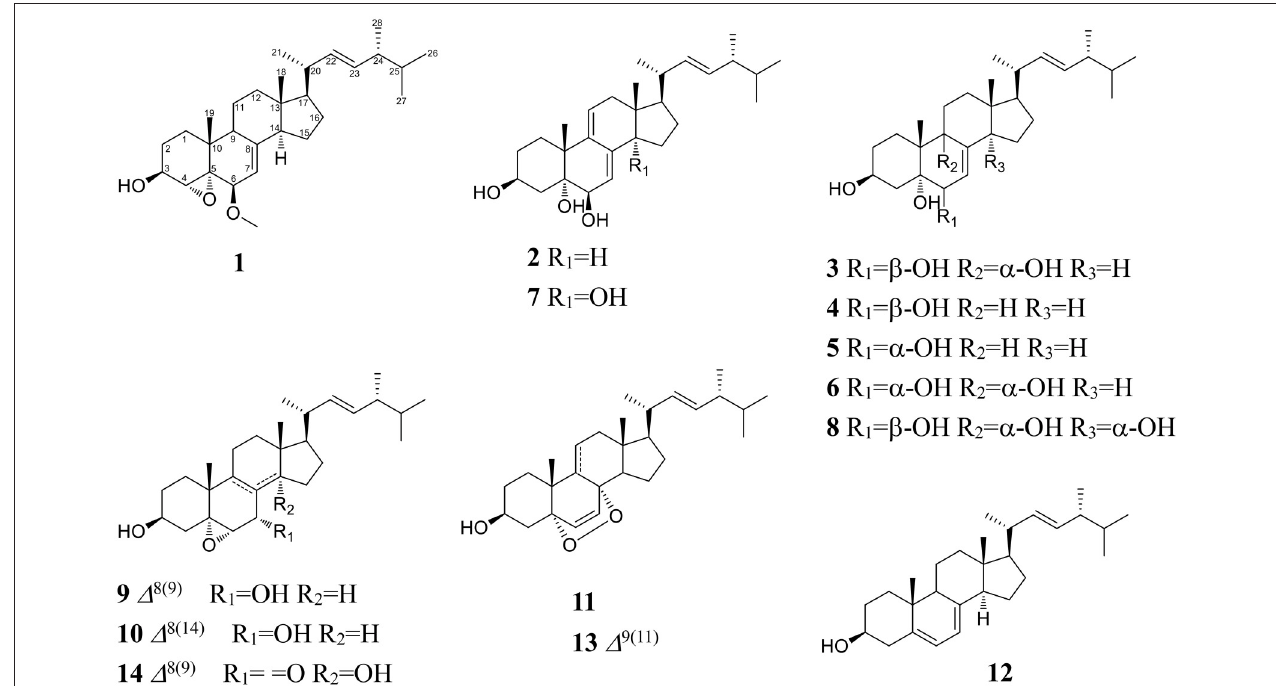
FIGURE 3 | Structures of compounds